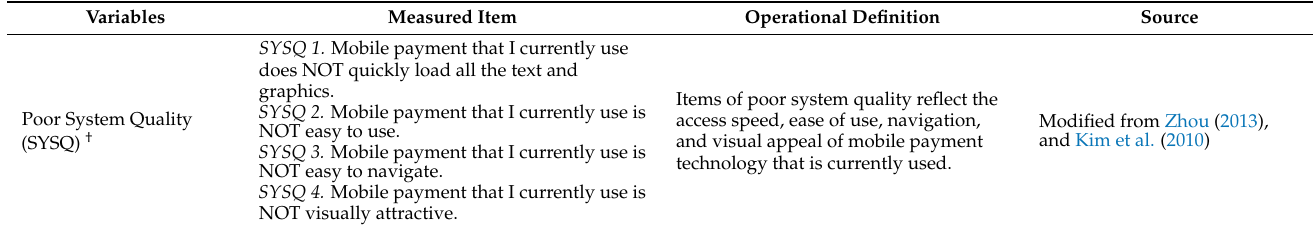
Table A1. The research model’s variables and